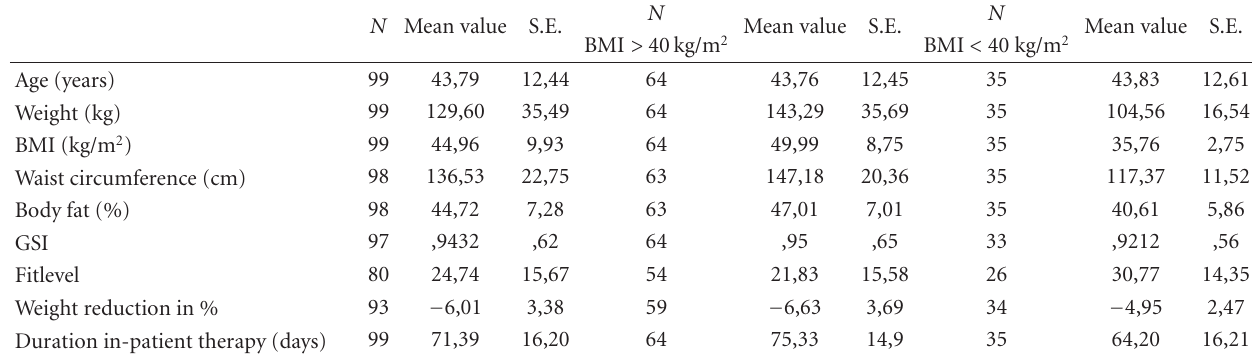
Table 4: Descriptive statistic of patients with BMI ≶ 40 kg/m 2 .